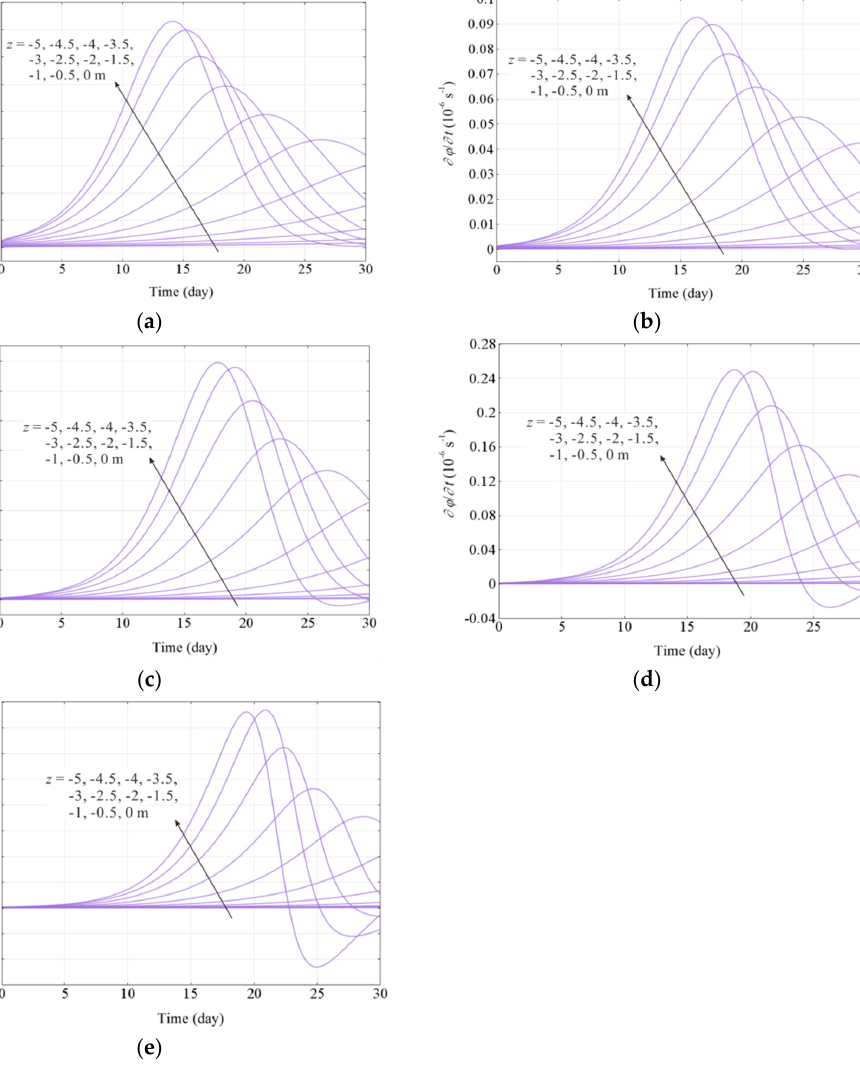
ϕ∂ Figure 17. Variations of ∂ϕ for different critical concentrations of the fluidized soil particles: ∂ t Figure 17. Variations of ∂ for different critical concentrations of the fluidized soil particles: ( a ) c cr t ( a ) c cr = 0.10; ( b ) c cr = 0.20; ( c ) c cr = 0.30; ( d ) c cr = 0.40; ( e ) c cr = = 0.10; ( b ) c cr = 0.20; ( c ) c cr = 0.30; ( d ) c c r = 0.40; ( e ) c cr = 0.50.